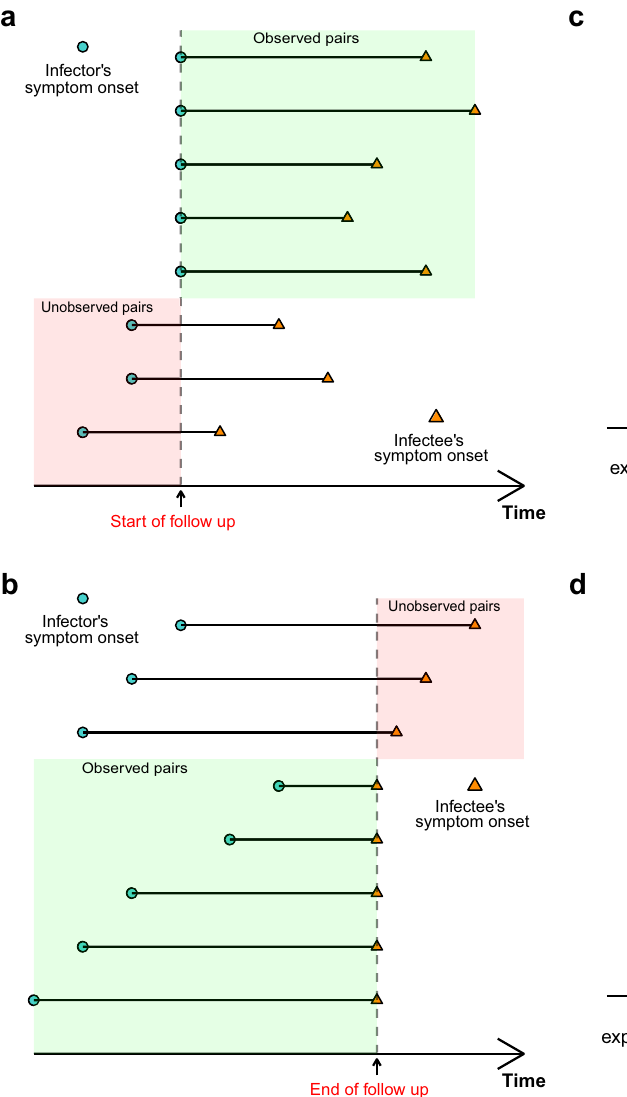
Fig. 2 | Censoring issues in sampling serial interval (SI) and corresponding inferential frameworks for generation time (GT). a Forward sampling with reference point as the start of the event leads to left censoring issue. b Backward samplingwithreferencepointastheendoftheeventleadstorightcensoringissue. The biases are due to failure in observing the sample under these forward and